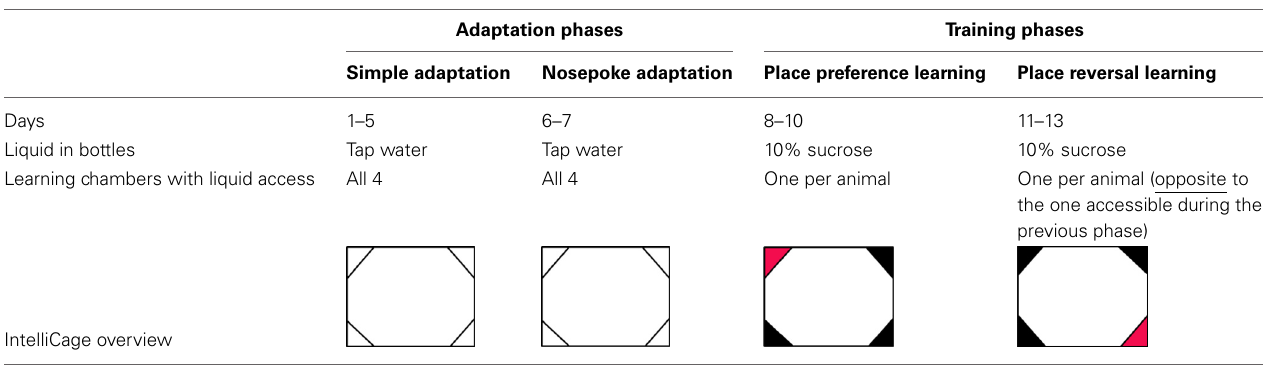
Table 1 | Scheme of the behavioral